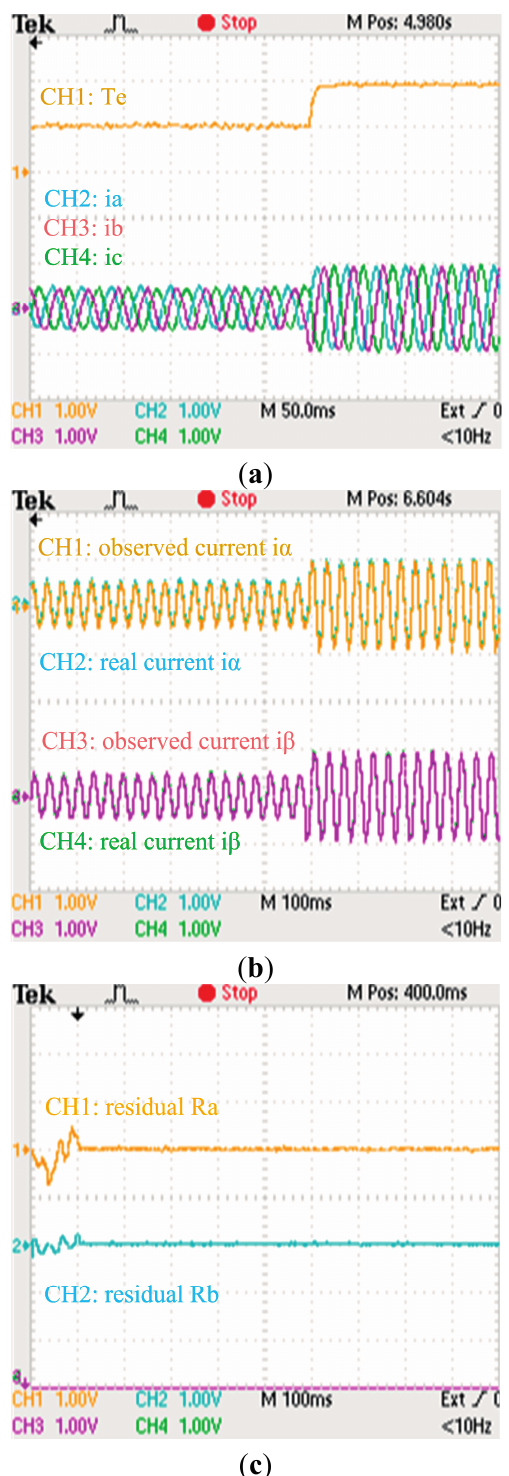
Figure 25. Experimental results when no fault is applied to the phase current sensors: ( a ) Zoom of experimental electromagnetic torque and phase currents responses; ( b ) Zoom of experimental actual and observing stator currents responses; ( c ) Zoom of experimental residual responses. (a) (torque: 500 Nm/div; current: 200 A/div; t: 50 ms/div); (b) (current: 200 A/div; t: 100 ms/div); (c) (residual: 1 A/div; t: 100